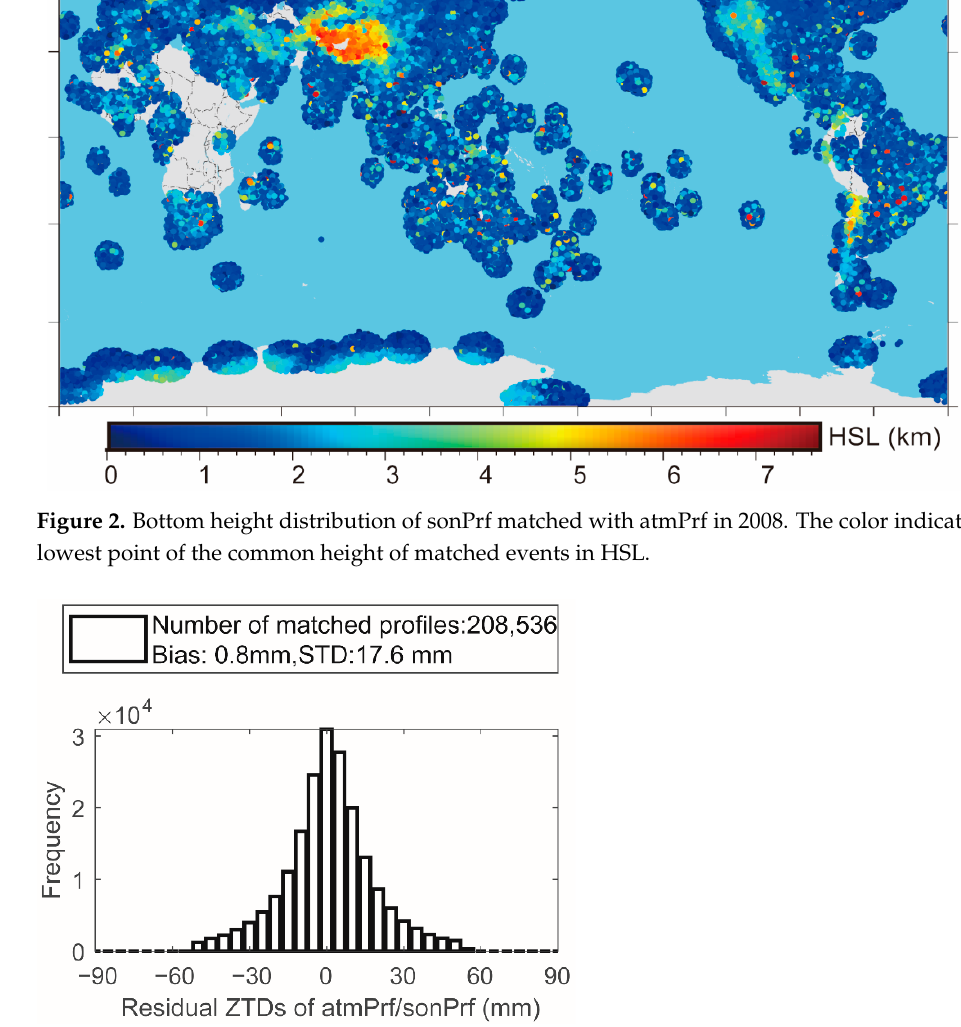
Figure 3. ZTD differences between matched atmPrf and sonPrf in 2008.